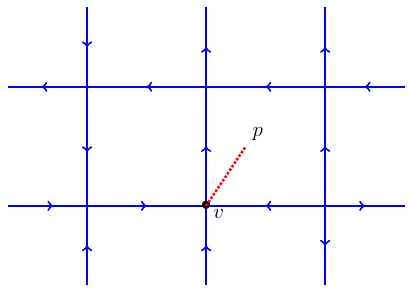
Figure 2 . This figure illustrates a choice of site (the dotted line) in the graph Γ . vertex v and represented by dotted lines as shown in figure 2. Both vertices and faces